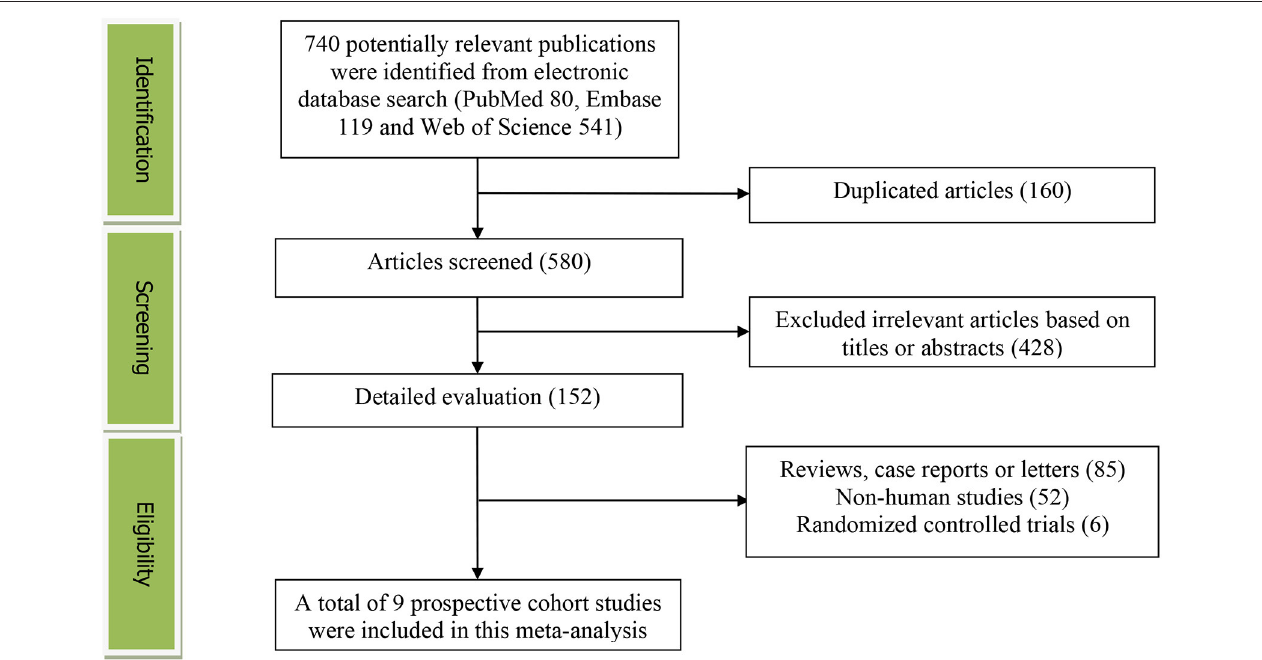
FIGURE 1 | The detailed flow diagram of the study identification and selection in this